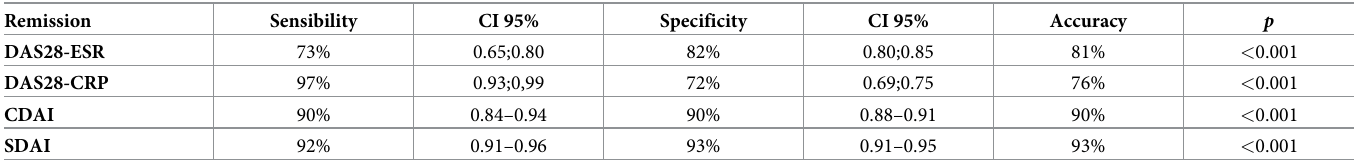
Table 9. Comparison of sensitivity and specificity among